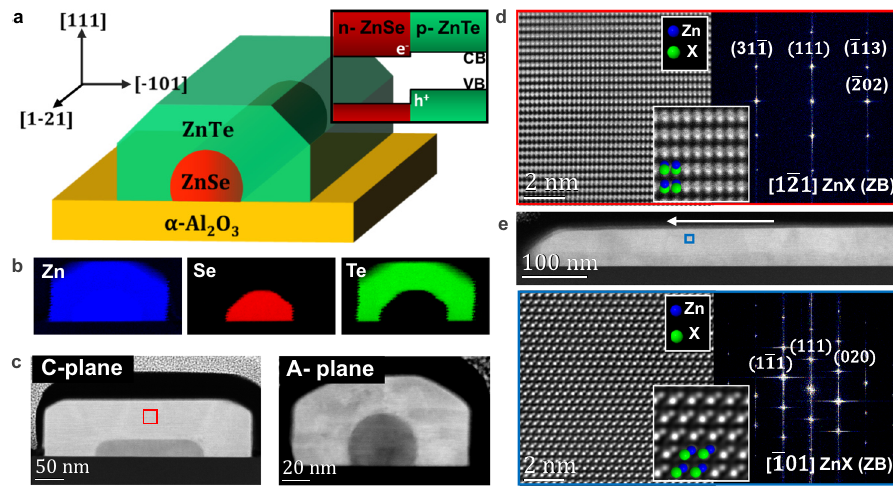
Fig. 1 Structure, composition and crystallographic orientations of sapphire-supported core-shell NWs. a Schematics of NW con fi guration, ZnX crystal directions (X = Se/Te) and core-shell band alignment. b EELS-based elemental maps for Zn (blue), Te (green) and Se (red). c Low-magni fi cation HAADF- STEM micrograph of NW transversal cross-sections on A-plane and C-plane sapphire. d Atomic-resolution HAADF-STEM detail and its corresponding power spectrum (FFT) of the transversal cross-section shown in ( c ). The inset reveals the atomic arrangement in more detail for precise chemical identi fi cation through the atomic-number contrast (Z-contrast). e Low-magni fi cation HAADF STEM micrograph of a longitudinal cut on a NW grown on C-plane sapphire, and higher magni fi cation detail (inset) with its corresponding FFT of the area highlighted with a blue